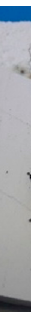
Figure 2. Mg-silicide uncoated after aging at 500 °C for 120 h, in air.